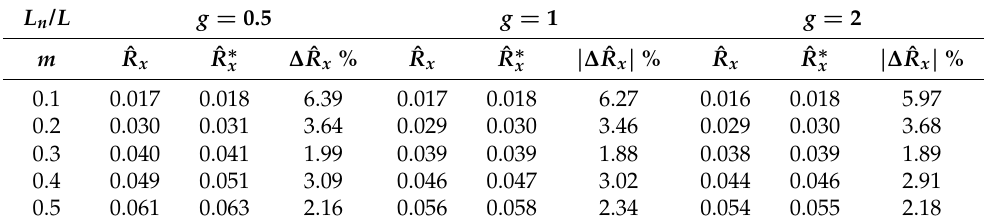
Figure 9. Experimental validation of normalized phase-current-ripple RMS in the case of SPWM for L n = L /2, L n = L , and L n = 2 L (i.e., g = 0.5, g = 1, and g = 2). Normalization base V dc / ( 2 Lf sw ) . Table 4. Phase-current-ripple RMS experimental errors assessment in the case of SPWM for L n = L /2, L n = L , and L n = 2 L (i.e., g = 0.5, g = 1, and g = 2).